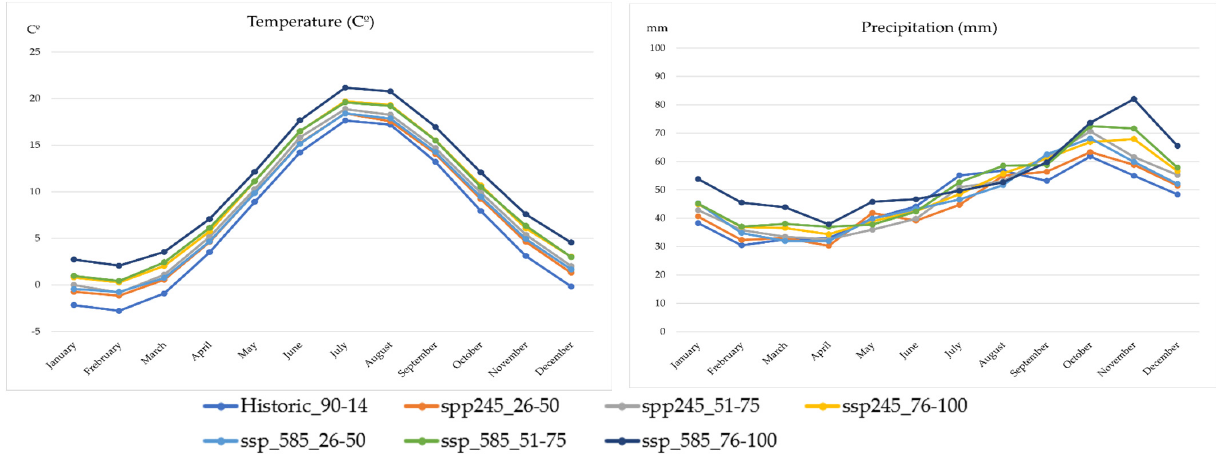
Figure 5. Comparison of monthly average precipitation and temperature in the Lake Erken basin for the periods and scenarios studied.